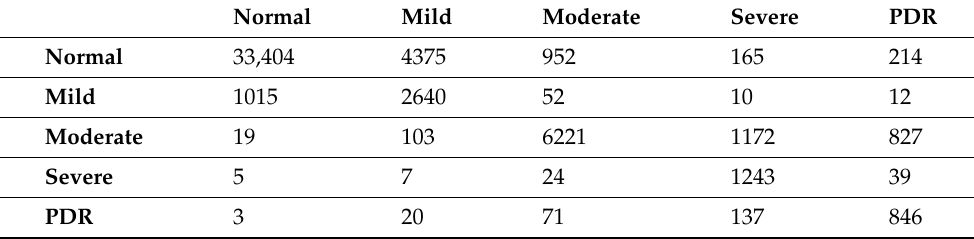
Table 10. Confusion matrix for most voted results of ensemble architecture, accuracy =